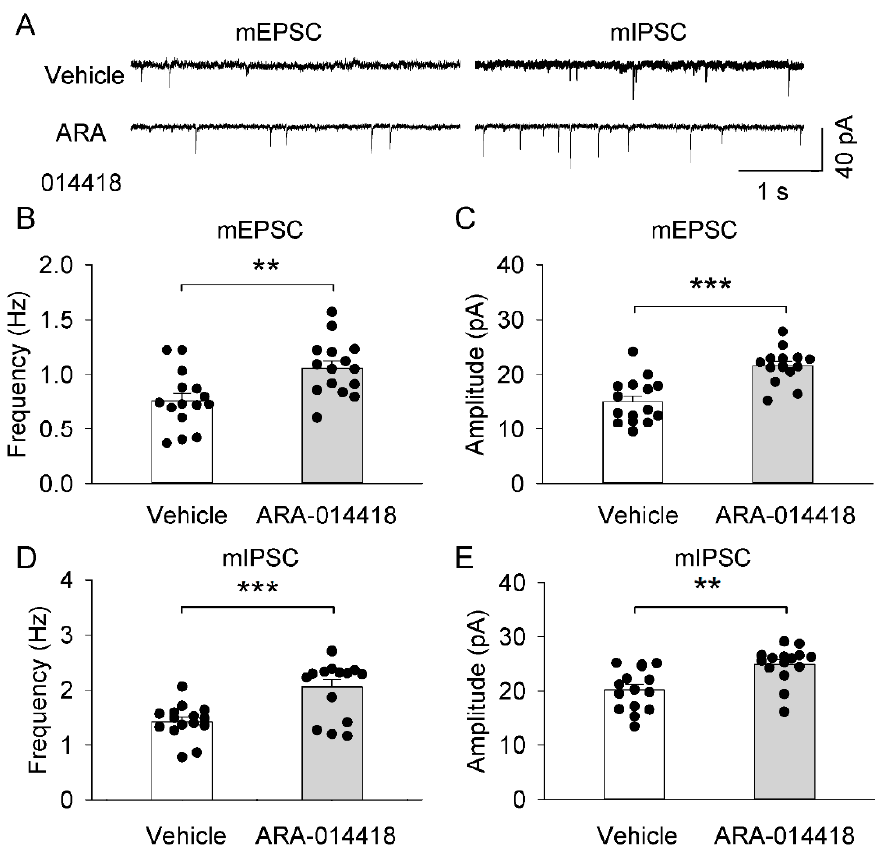
Figure 6. GSK3 β inhibitor (ARA-014418) increased synaptic transmissions of 3 × Tg-AD mice. ( A ) Representative mEPSCs and mIPSCs were recorded from prefrontal cortex pyramidal neurons in slices prepared from mice microinjected with vehicle or ARA-014418. ( B , C ) The mean frequency ( B ) and amplitude ( C ) of mEPSCs in the prefrontal cortex in these two groups of mice. The mean frequency (** p = 0.004, n = 15-15) and amplitude (*** p < 0.001, n = 15-15) of mEPSCs were significantly increased in the ARA-014418 group compared to the vehicle group. ( D , E ) The mean frequency ( D ) and amplitude ( E ) of mIPSCs in the prefrontal cortex in these two groups of mice. The mean frequency (*** p < 0.001, n = 15-15) and amplitude (** p = 0.001, n = 15-15) of mIPSCs were significantly increased in the ARA-014418 group compared to the vehicle group. Each data set was obtained from 6 mice.